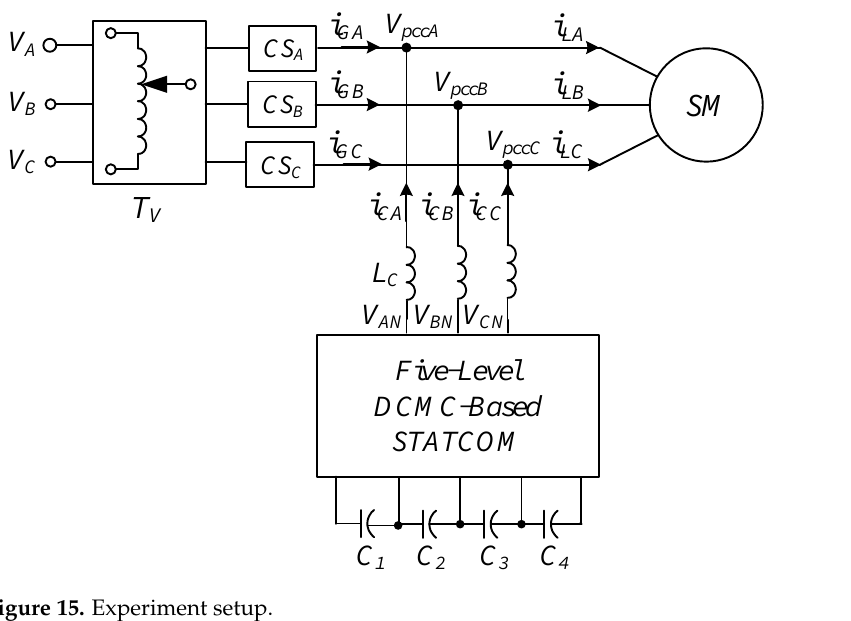
Figure 14. 2 kVA five-level DCMC-based STATCOM prototype.